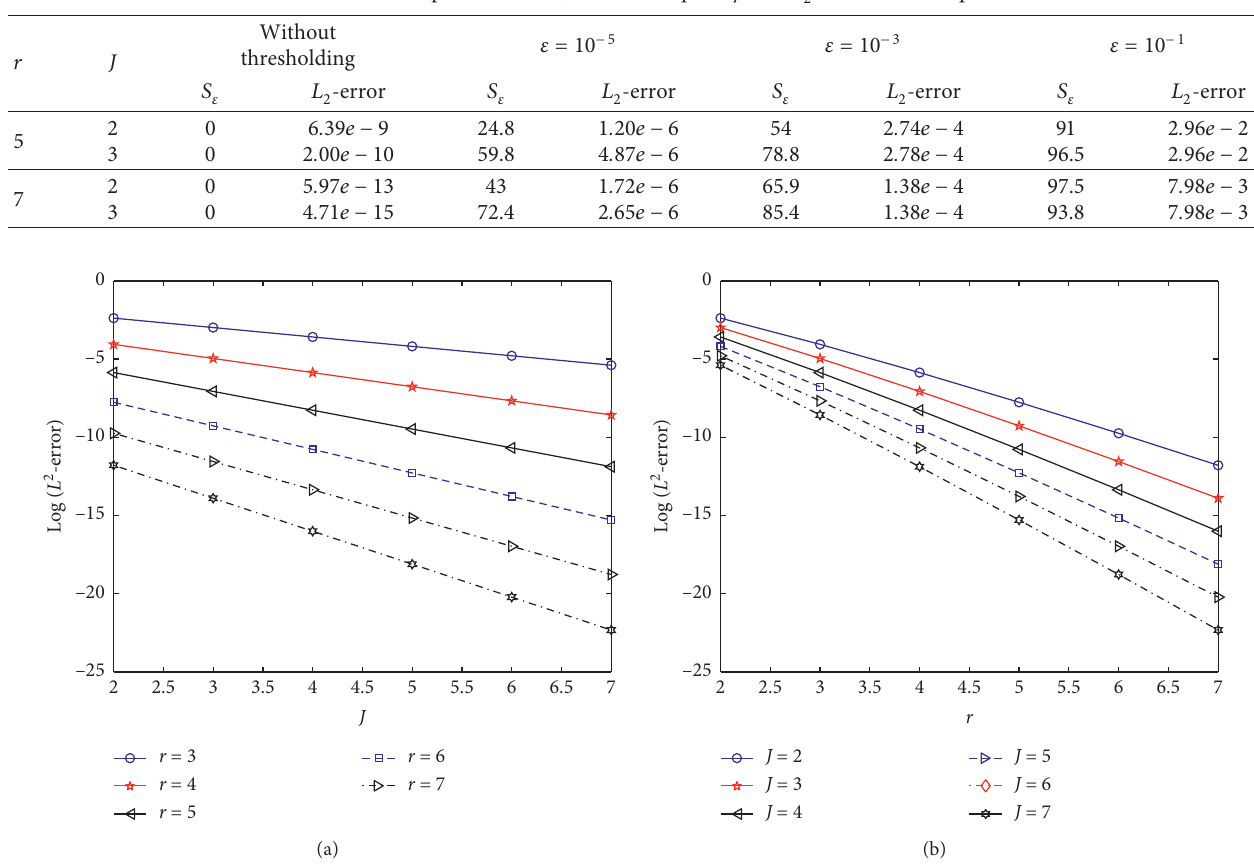
Table 1: Effects of parameters r , J , and ε on sparsity and L